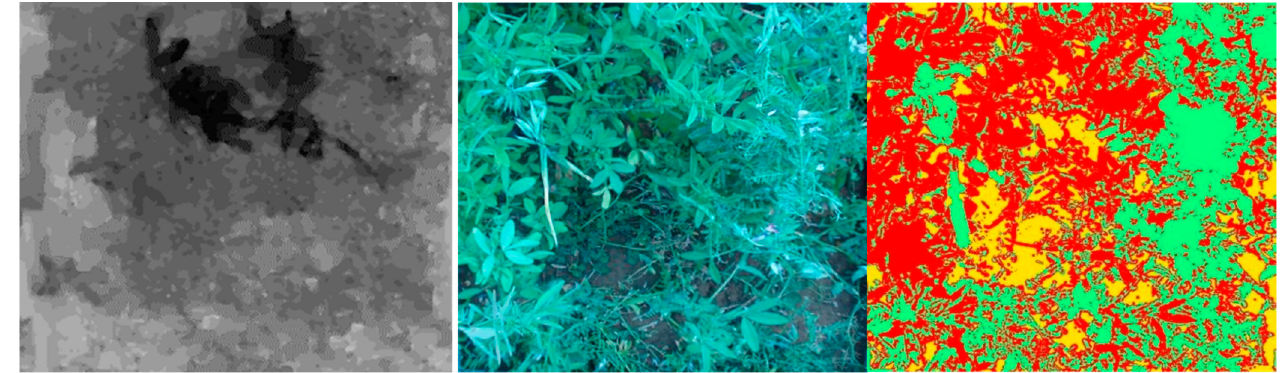
Figure 1. Examples of Lytro photographs. ( Center ) the fully focused image. ( left ) the depth map. ( right ) one example of segmentation (the soil is in yellow, Trifolium alexandrinum , is in red, Viscia sativa is in green).